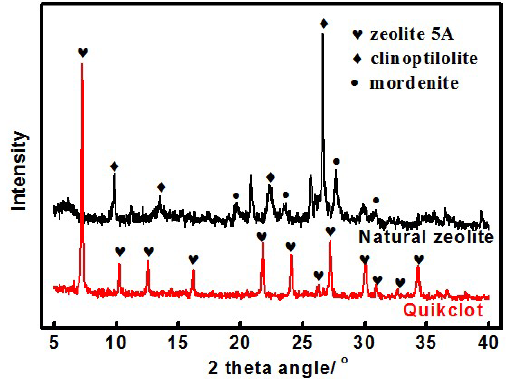
Figure 1. Powder X-ray diffraction pattern of Quikclot and NZG-JY (natural zeolite granules from Jinyun, China). Heart shapes identify reflections associated with the zeolite LTA-5A in Quikclot. Rhombus shapes indicate the high content of clinoptilolite in NZG-JY, and circular shapes indicate mordenite.